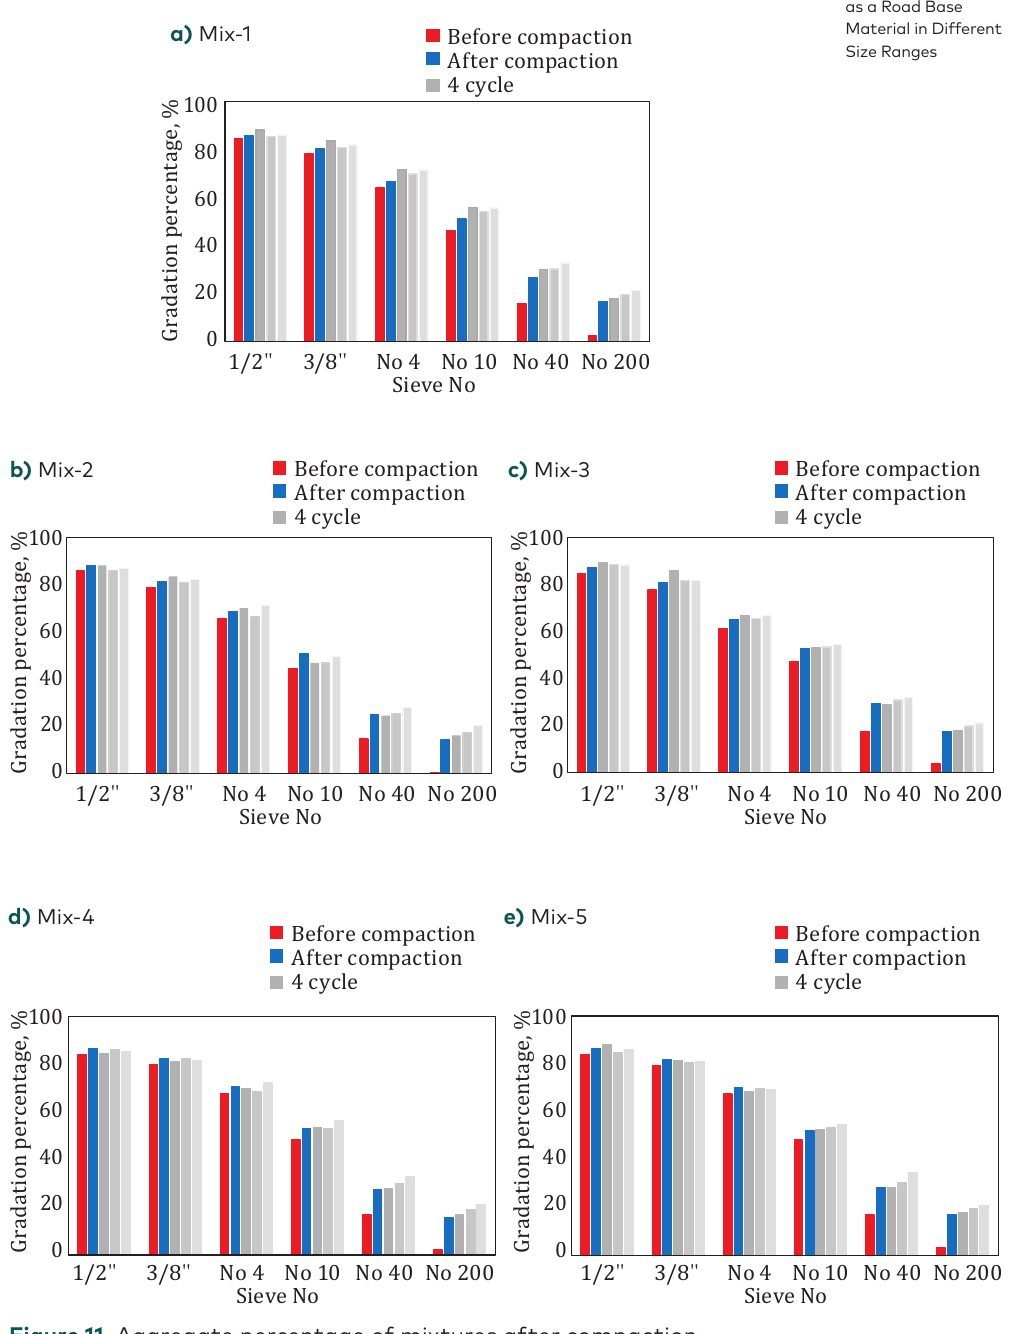
Figure 11. Aggregate percentage of mixtures after compaction and freeze-thaw: a) Mix-1; b) Mix-2; c) Mix-3; d) Mix-4; e)